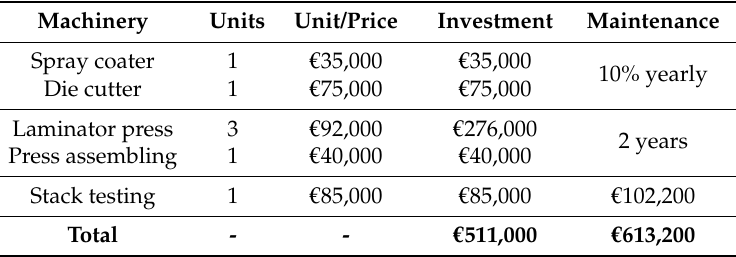
Table 3. Investment in machinery for stack